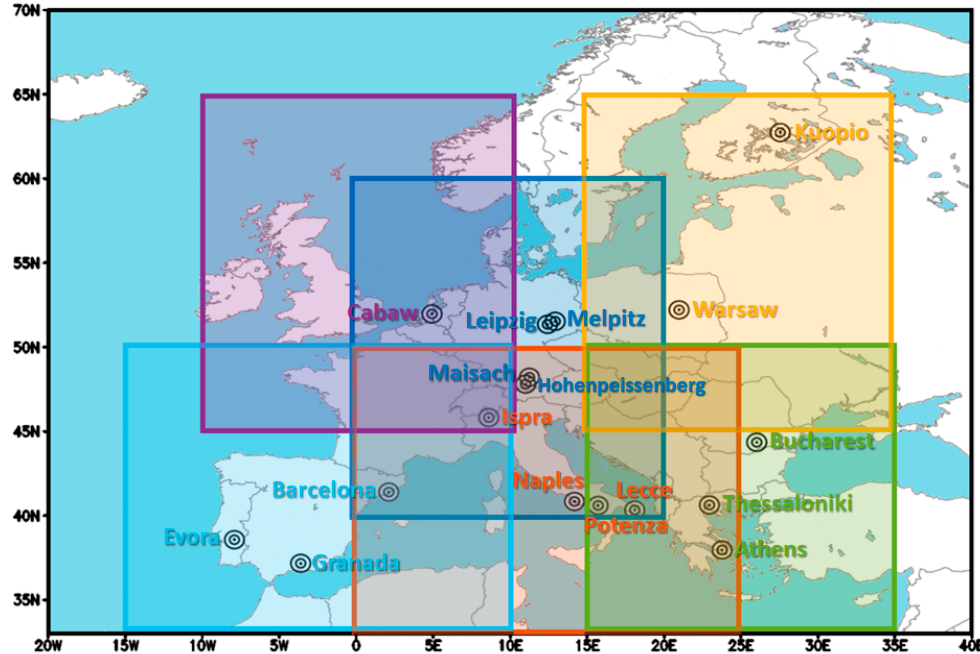
Figure 1. Cluster domains: Central (in blue, containing Hohenspeissenberg, Leipzig, Maisach, and Melpitz), Southeast (in green, containing Athens, Bucharest, and Thessaloniki), Mediterranean (in orange, containing Ispra, Lecce, Naples, and Potenza), Southwest (in cyan, containing Barcelona, Evora, and Granada), Northwest (in magenta, containing Cabaw), and Northeast (in yellow, containing Kuopio and Warsaw).